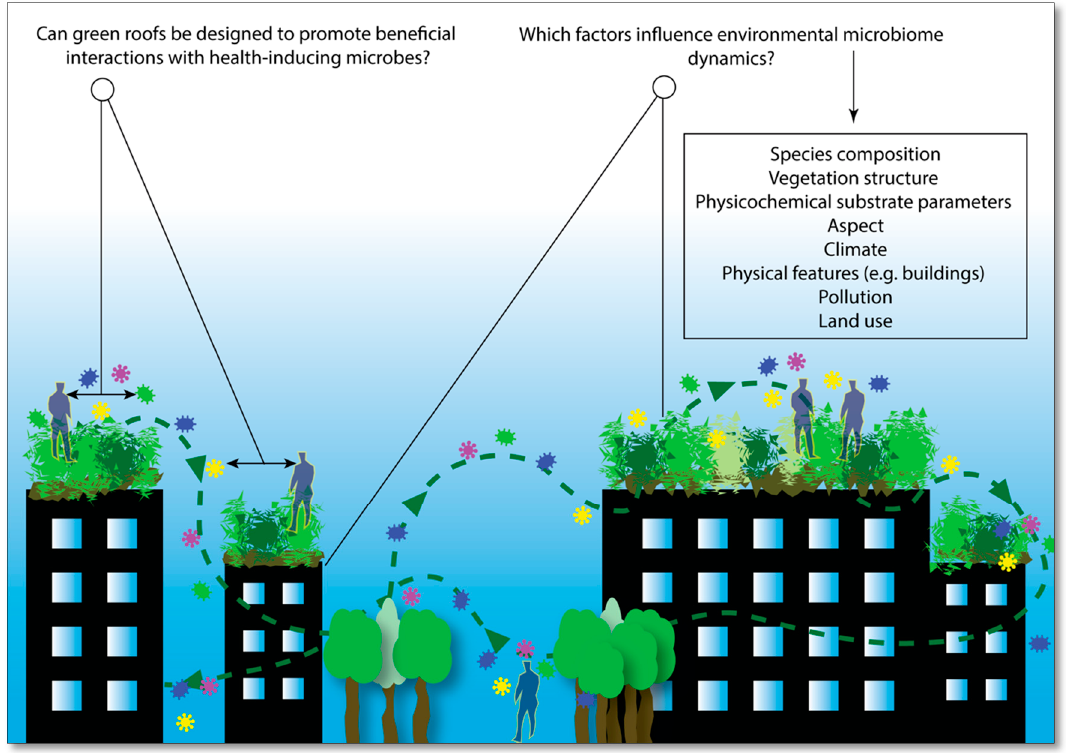
Figure 1. Could green roofs be designed and manipulated to promote beneficial interactions with health-inducing microbial assemblages, i.e., ‘old friends’? (created by the author, from Reference [63]).